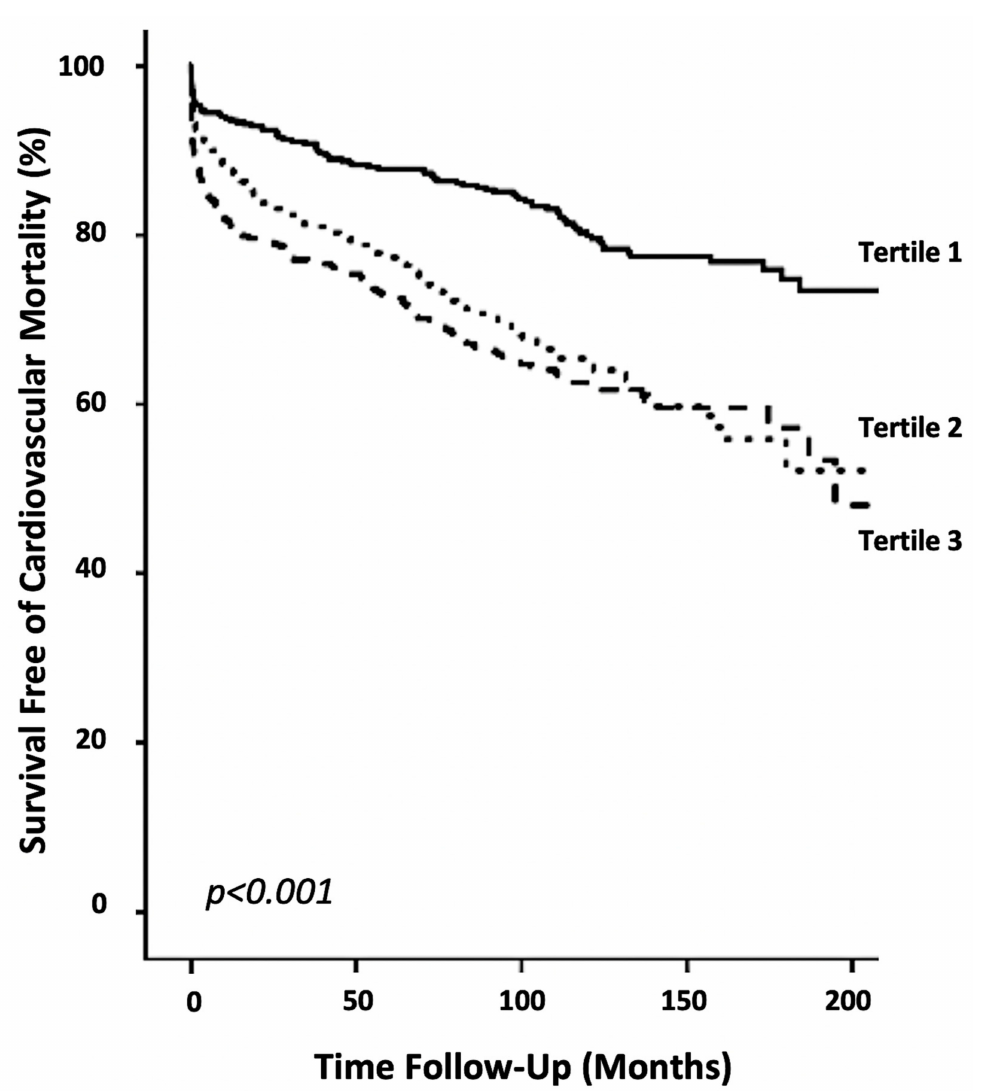
Figure 1. Survival curves of cardiovascular mortality. Kaplan–Meier plots showing cardiovascular mortality within tertiles of the De-Ritis ratio ( p <